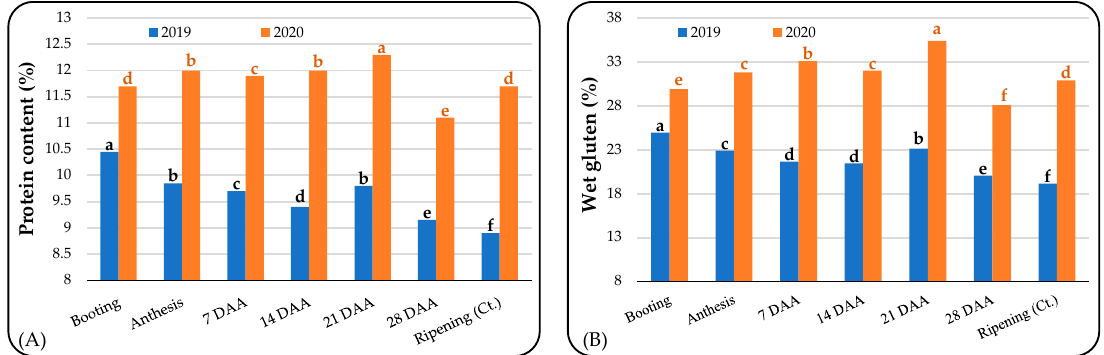
Figure 7. The variation of grain-quality indices (( A ) protein content; ( B ) wet gluten content) under different flag leaf removal stages in Codru variety. Different letters in ( A ) and ( B ) figures, the significance is represented according to Duncan Test.